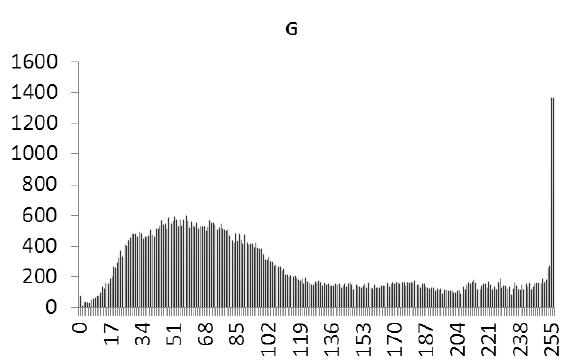
Figure 27. Statistical chart of G value distribution of the original image.